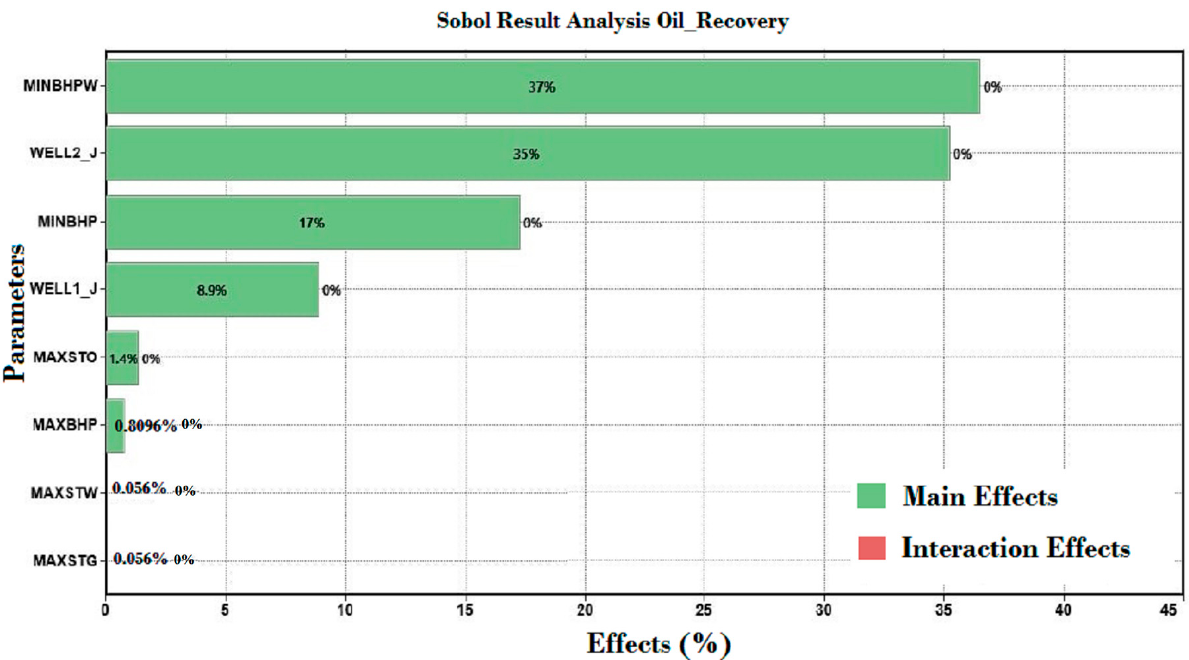
Figure 12. Sobol analysis results distinguishing the most influential decision variables affecting the TC-GDWS-AGD simulation cases evaluated by PSO.